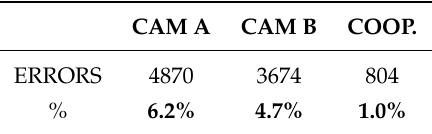
Table 7. Cooperative monitoring